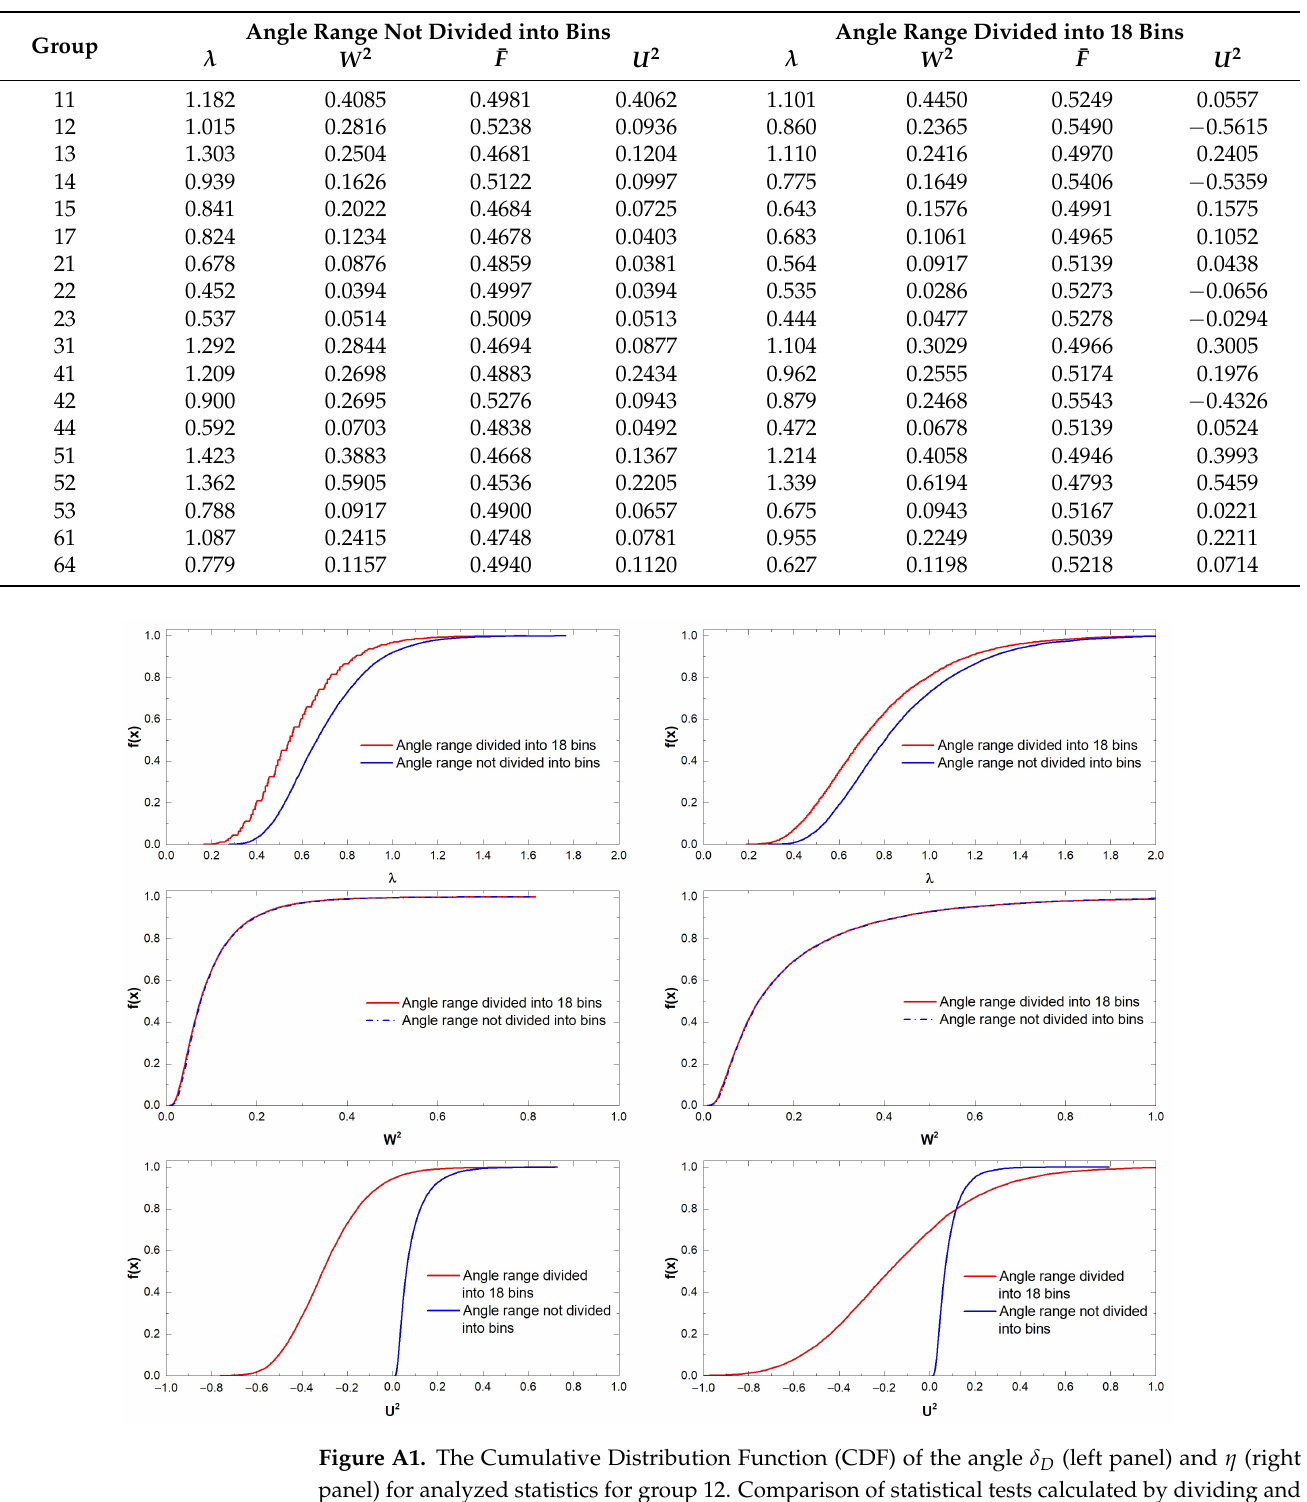
Table A4. Comparison of statistical tests calculated by dividing and not dividing the range of the analyzed angle η into bins, with the inclination obtained by taking into account the morphological types of galaxies and the Fouque and Paturel correction.